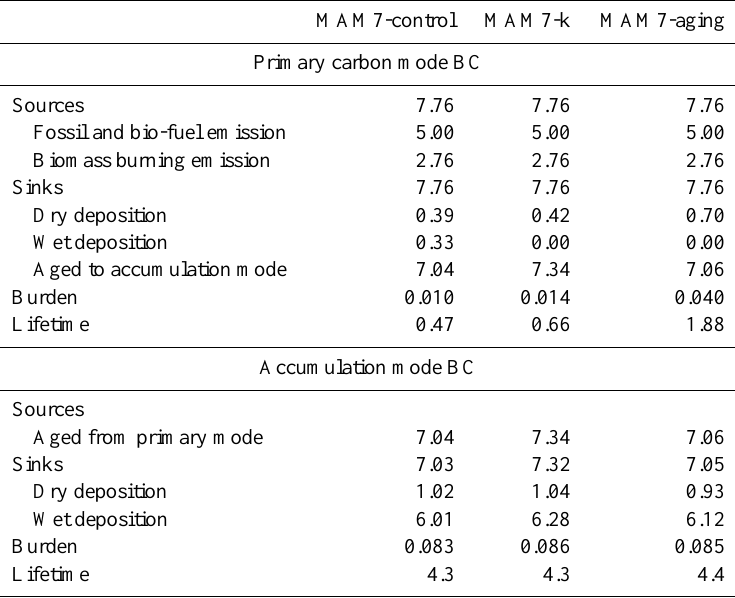
Table 12. Global budgets for primary carbon mode and accumulation mode BC from the standard MAM7 simulation (MAM7-control) and the MAM7-k and MAM7-aging sensitivity